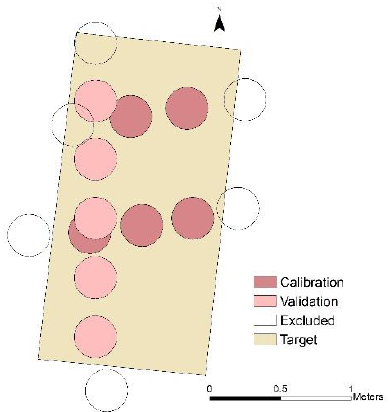
Figure 3. Illustration of the C2 footprints (at 1 / e 2 ) on the open target.